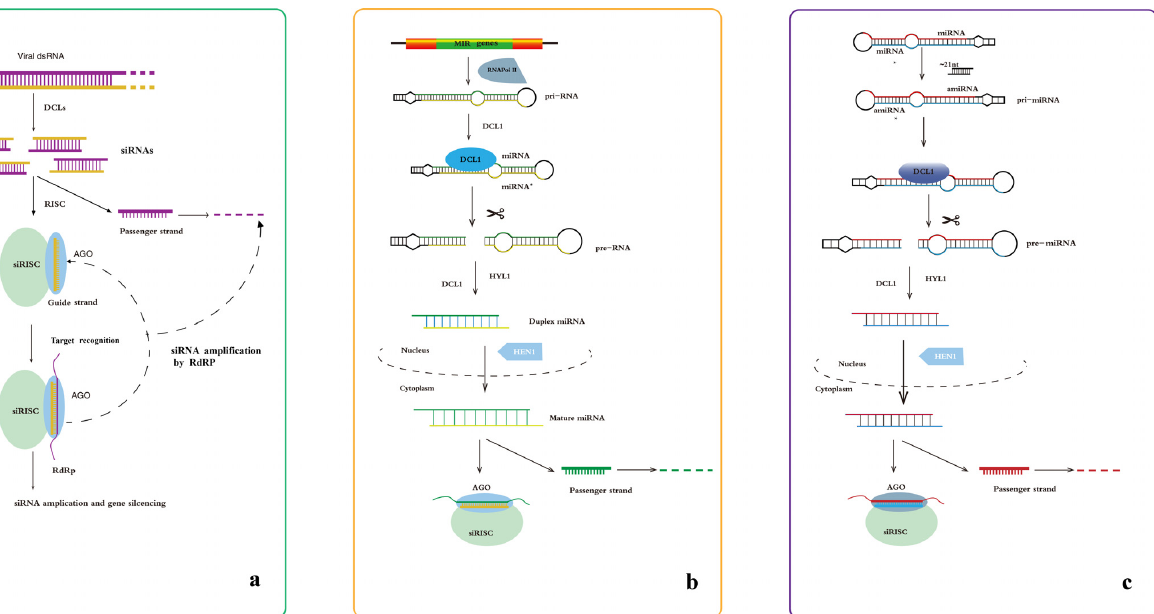
Table 1. Summary of the application of RNA silencing to the viral pathogens of potato.